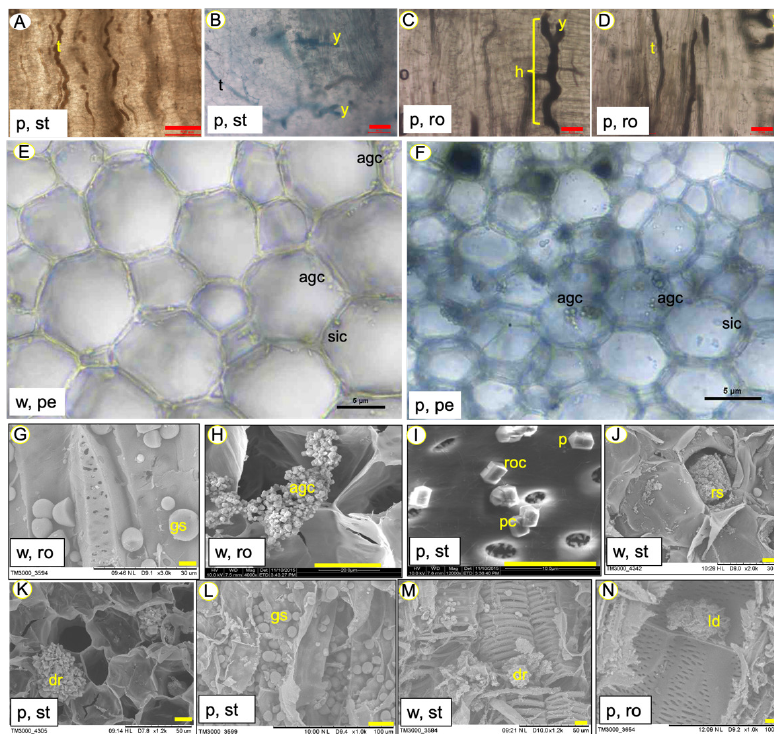
Figure 6 : Latex and crystal forms found in different parts of the two forms of Calotropis gigantea. Top two rows: Light microscopy, last two rows, SEM. (A) longitudinal tangential section of wood showing latex traces and tubular-shaped laticifers in the stem. (B) bifurcate or Y- Y-shaped and tubular-shaped laticifers in stem in transverse section (TS), stained with TBO. (C) bifurcate and tubular shape, H shape laticifers in root. (D) Y and H-shape laticifers in the root. (E) aggregated and single crystals in the petiole of white form. (F) aggregated and single crystals in the petiole of purple form. (G) heavily deposited, different shapes of crystals gathered to form compound crystals in pith parenchyma of the root of white form. (H) heavily aggregated a form of crystals in the root of white form. (I) different shapes (prismatic shaped, rhomboid) of crystals inside the stem vessels. (J) rhomboid shape crystals. (K) druse inside the stem parenchyma cells. (L) globular shape crystals inside parenchyma cells. (M) druse outside parenchyma cells. (N) irregularly shaped deposits of latex in root vessels. Sub-figure letters: pp - purple, petiole. ps - purple stem. pr - purple, root. wp - white, petiole. ws - white, stem. wr - white, root. Abbreviations used: agc - aggregated crystals. cc - compound crystals. dr - druse. gs: globular shape crystals. h - H-shaped laticifers. is: irregular shape crystals. ld: latex deposits in vessels. p: prismatic shape crystals. ro: rhomboid shape crystals. sic - single crystal. t: tubular-shape laticifers. Y: Y- Y-shaped laticifers. Sub-figure letters - pr: purple root. ps: purple stem. wr - white root. ws - white stem. Scale bar: 5 µm: E, F; 10 µm: I; 20 µm: H; 30 µm: G, J; 50 µm: K, M; 100 µm: B, C, D, N; 500 µm: